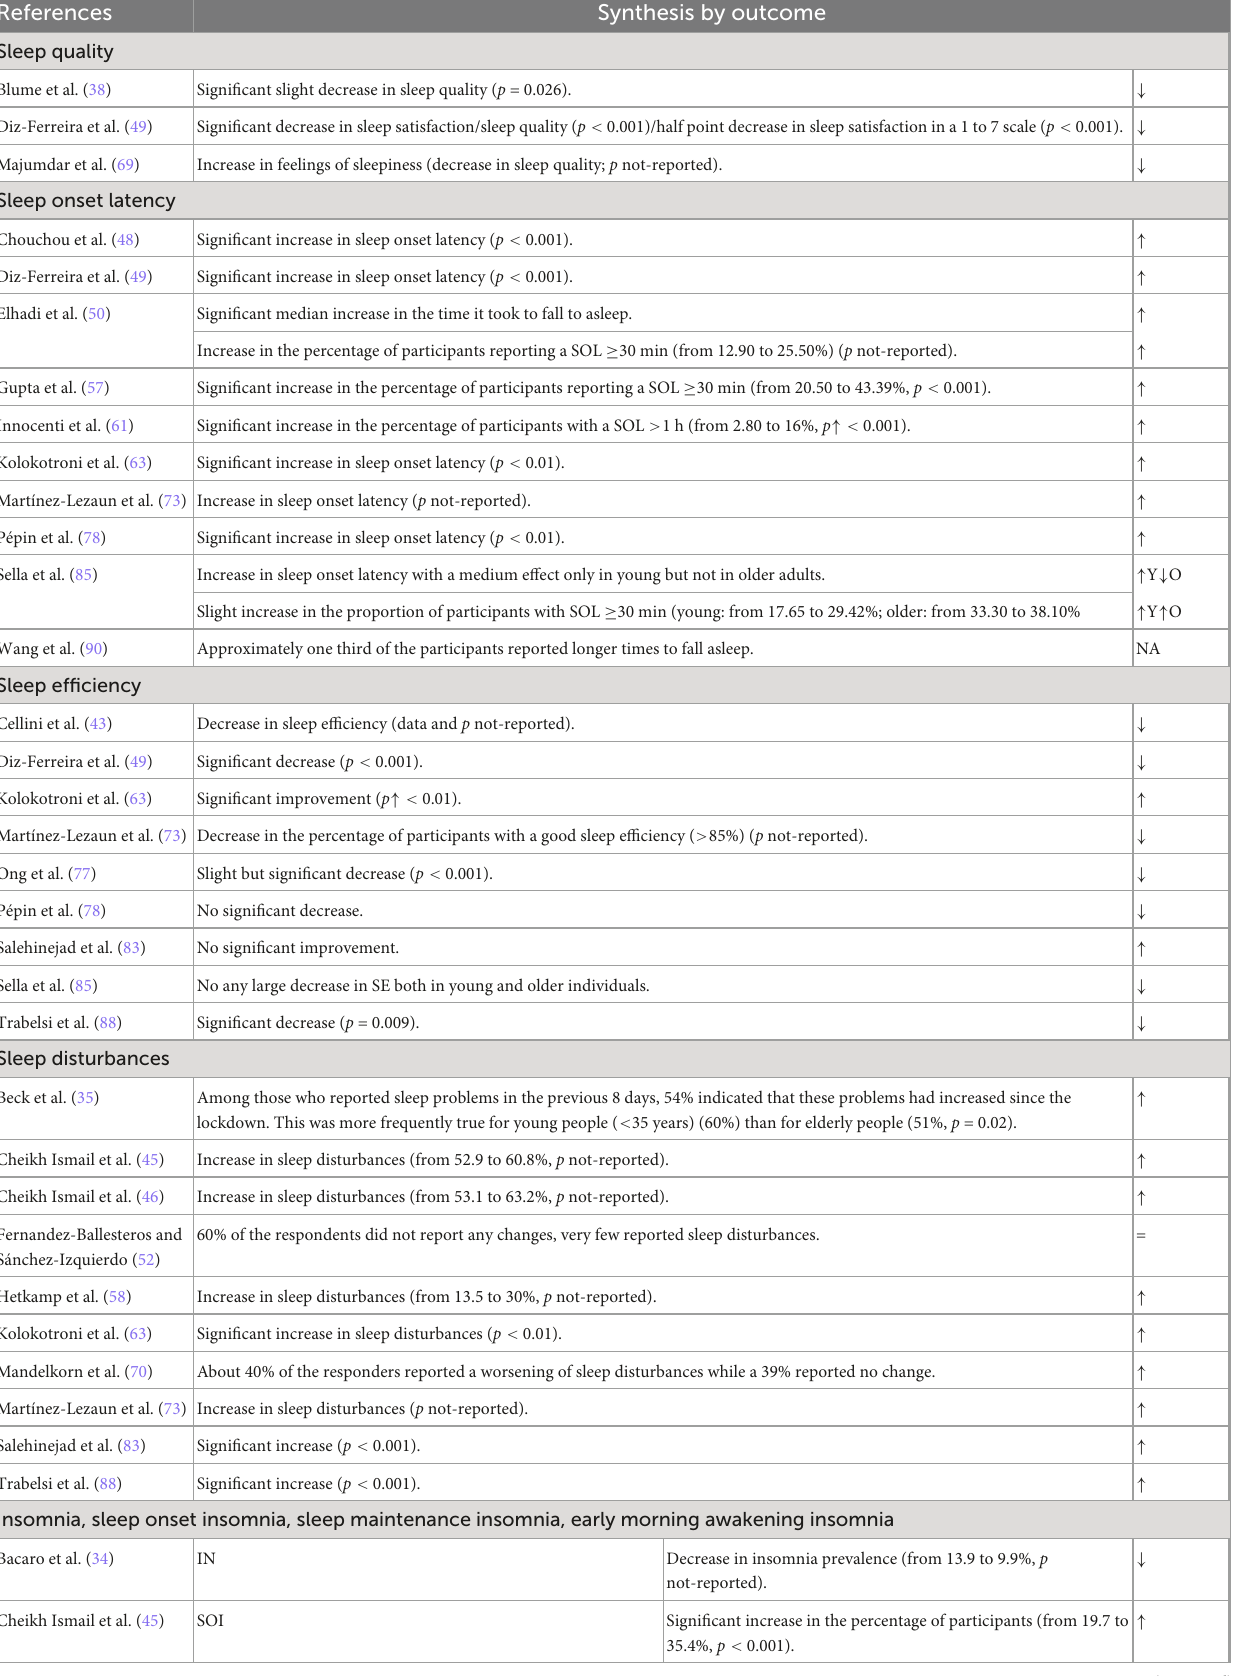
TABLE 2 Synthesis of changes in sleep outcomes from before to during the COVID-19